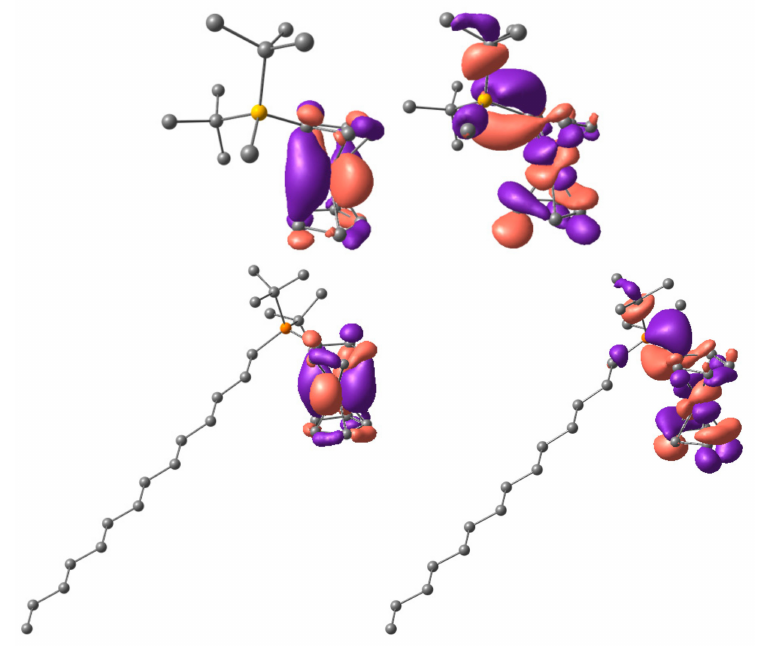
Figure 6. HOMO ( left ) and LUMO ( right ) of m1 ( top ) and m9 ( bottom ). For m1 and m9 , ion pairs with Br − and [BF 4 ] − counterions were optimized (Figure 7). According to our computations, the energy of ion pairing is higher by 6–8 kcal/mol for Br − anion compared to [BF 4 ] − (84 vs. 78 kcal/mol for Fc-P + ( t -Bu) 2 CH 3 and 85 vs. 77 for Fc-P + ( t -Bu) 2 C 14 H 29